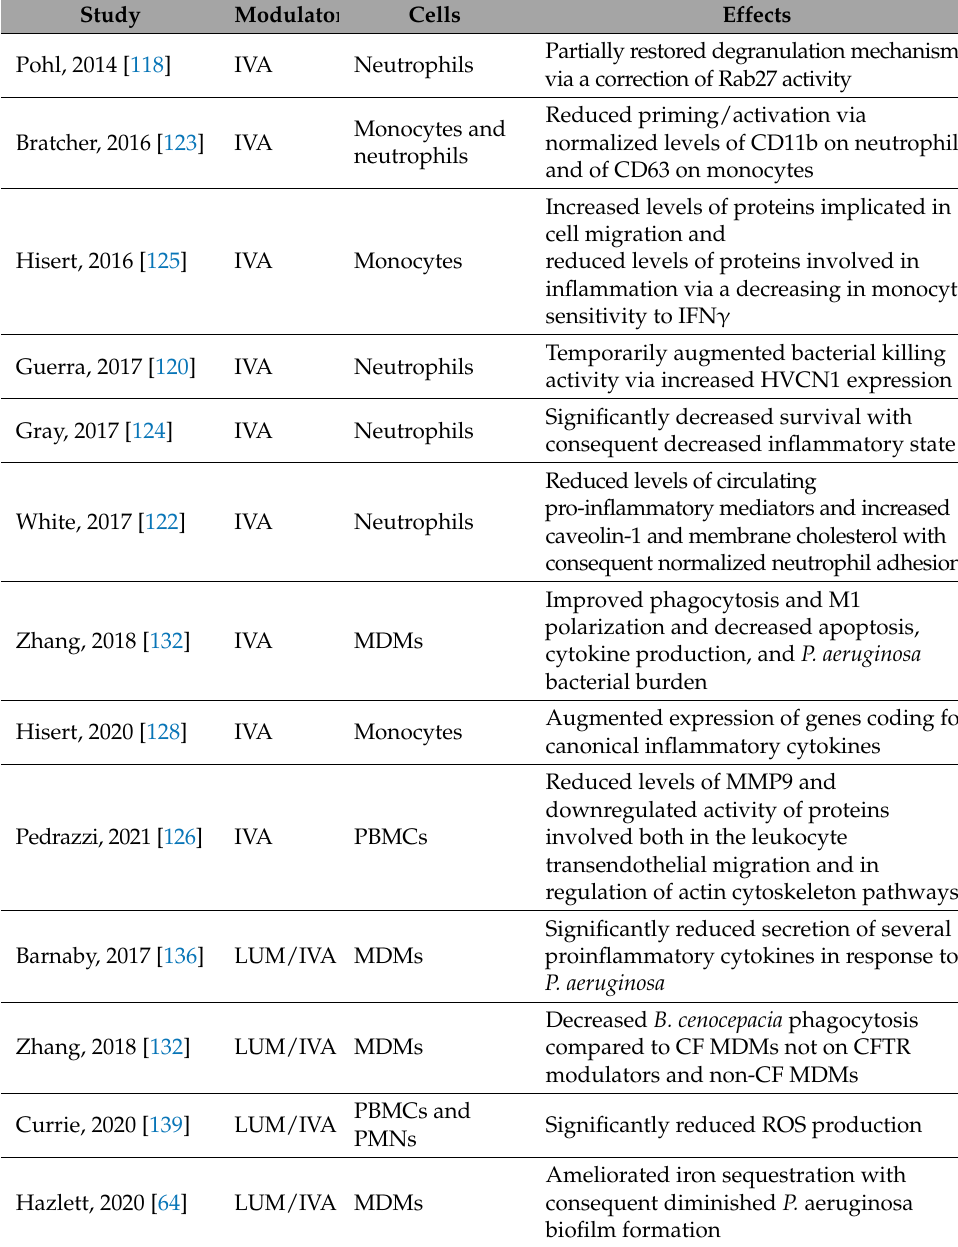
Table 2. The effects of CFTR modulators on